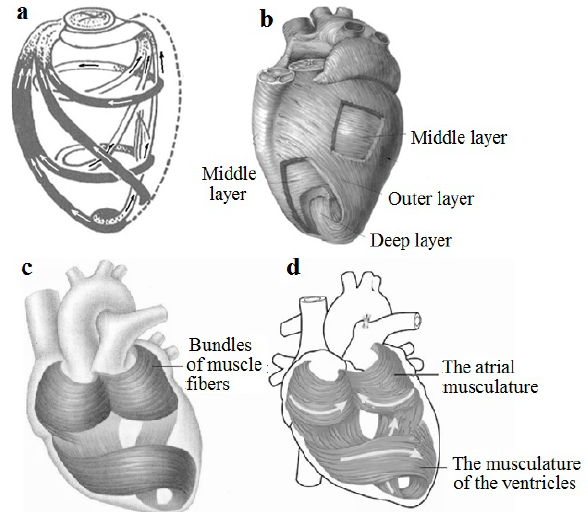
Fig. 13. Schematic representation of the structure of muscle fibers of the heart [26, p. 89-91]. Each bundle of fibers encircles the ventricles of the heart, from the top of the heart to the aorta a) Muscle fibers of the heart spiral down to the top of the heart, and then rise again to its base, forming a chiral system [26, pp. 89-91]. b) shows the anatomical structure of the muscle fibers of the heart. Each bundle of fibers encircles the ventricles of the heart from the top to the base, forming a chiral fiber system. b) shows the anatomical structure of the muscle fibers of the heart. The muscle fibers of the atrium also form the chiral system, as seen in Fig. 13 in